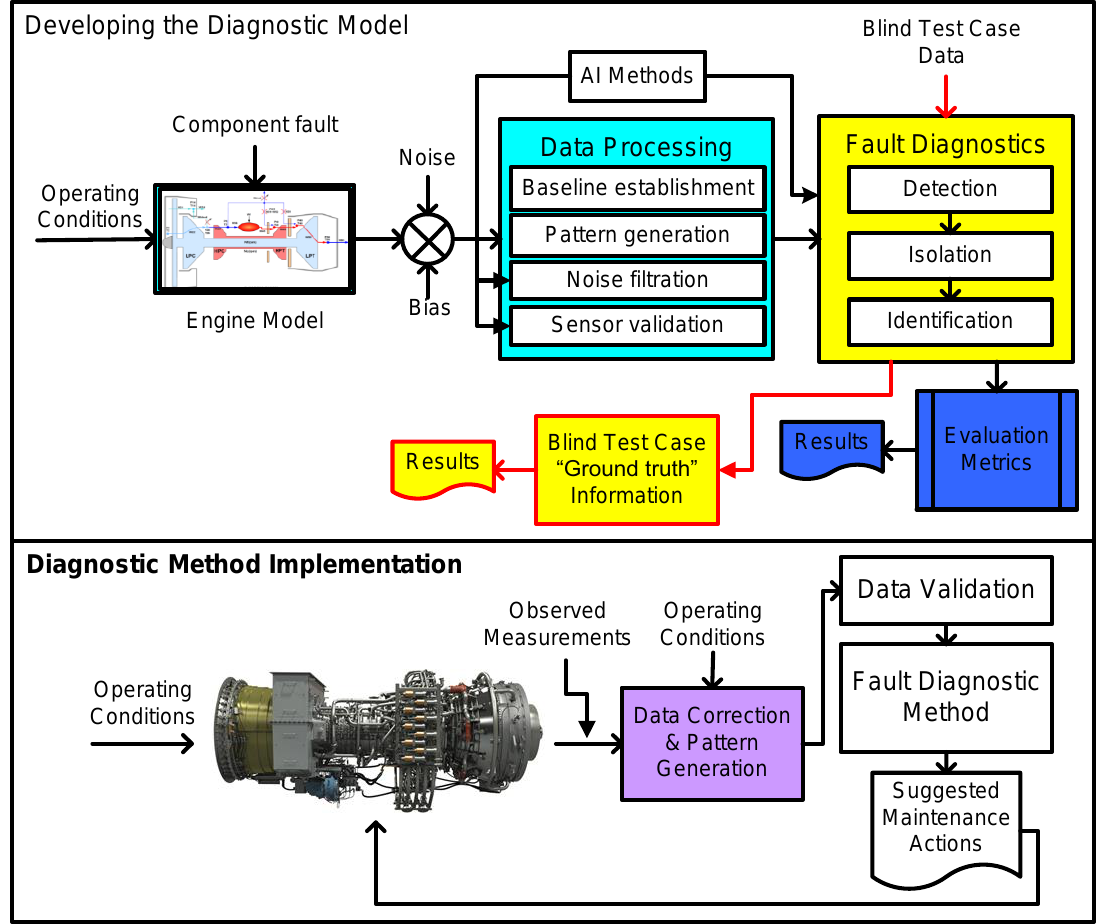
Figure 7. Schematics of the general AI-based GT fault diagnostic procedures. Section 1: major tasks in developing engine diagnostics model; Section 2: the testing steps.